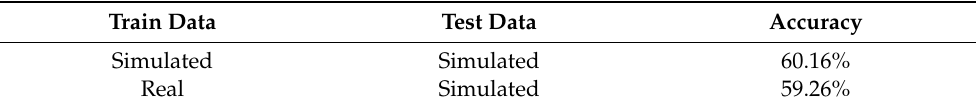
Table 6. Cross-validation for testing the simulated Video-SAR data.